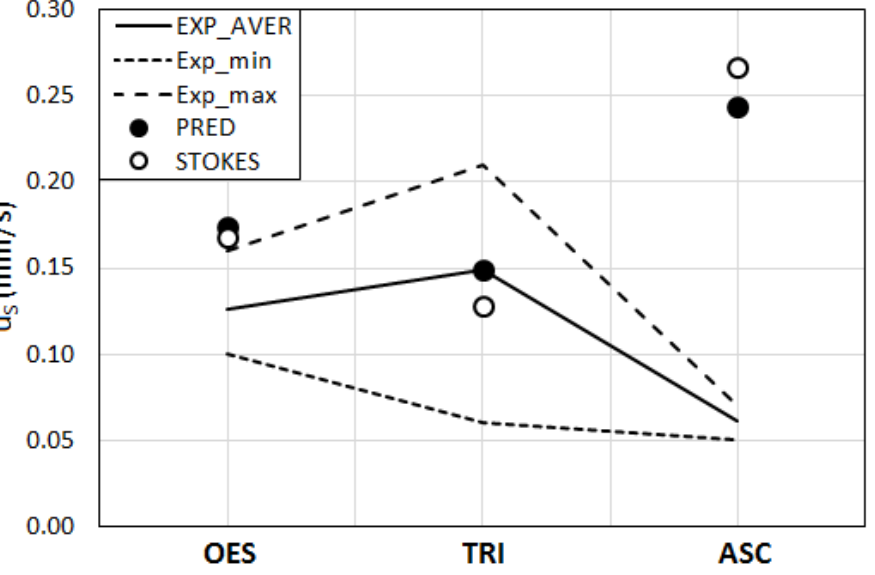
Figure 13. Presently predicted (PRED), experimental (EXP) and by the Stokes law (STOKES) provided sink velocities (u S ), for the three egg types, OES, TRI and ASC. Minimum (Exp_min) and maximum (Exp_max) values obtained in the experiments [20] are also shown.